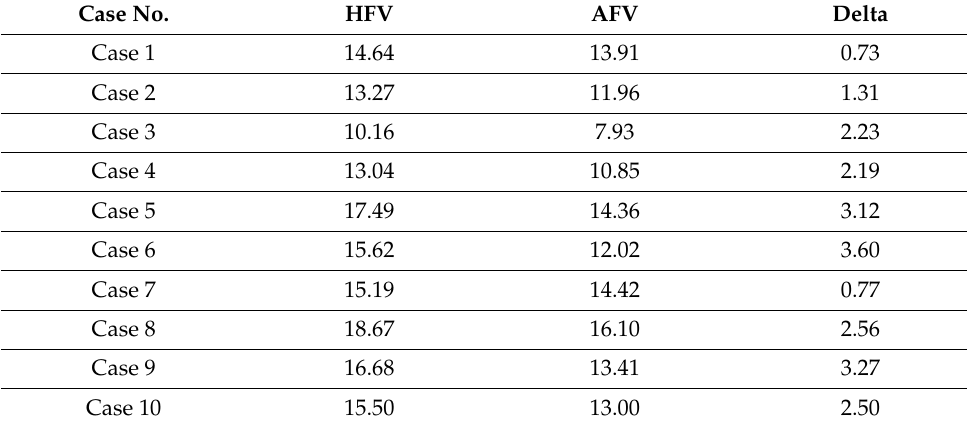
Table 3. Volume measurement of the fat tissue.